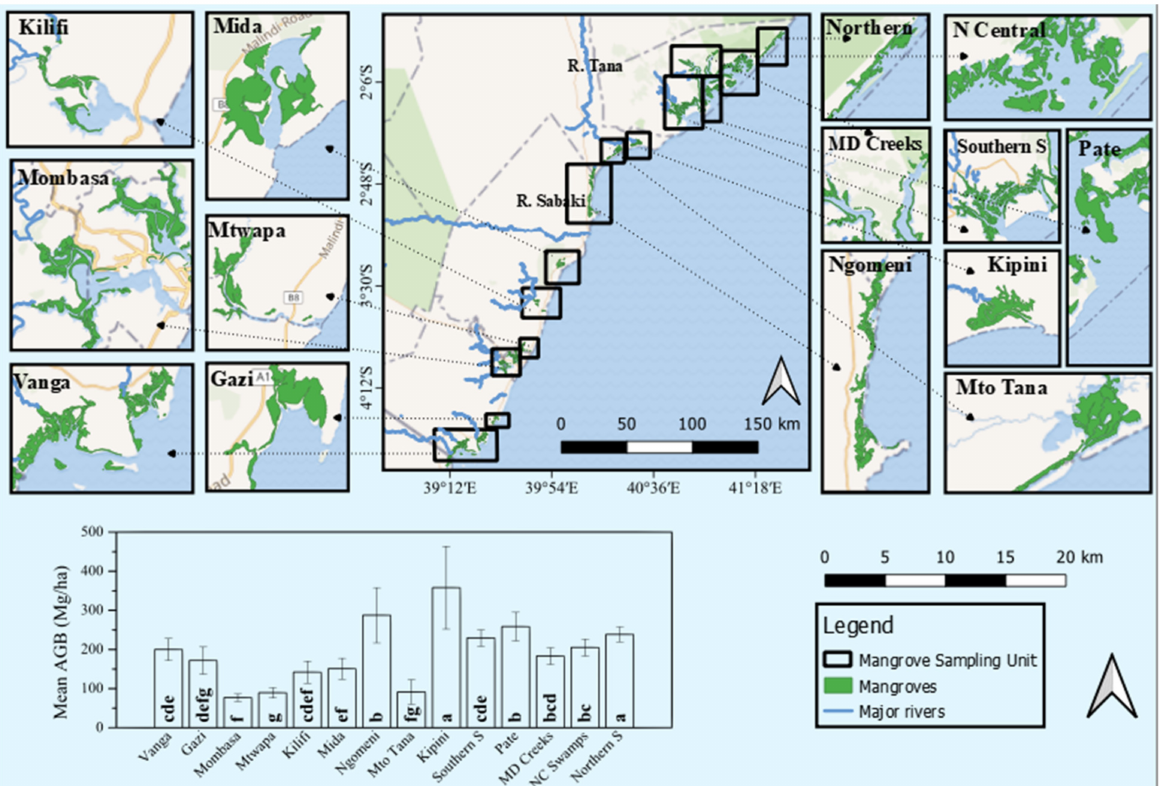
Figure 5. Map of the 14 mangrove sampling sites along the coast of Kenya featuring mean above- ground biomass (Mg/ha) in each site. The error bars are standard error bars, and the letters denote the grouping information from the Tukey Pairwise comparison post-hoc test at 95% confidence level—the means that do not share a letter are significantly